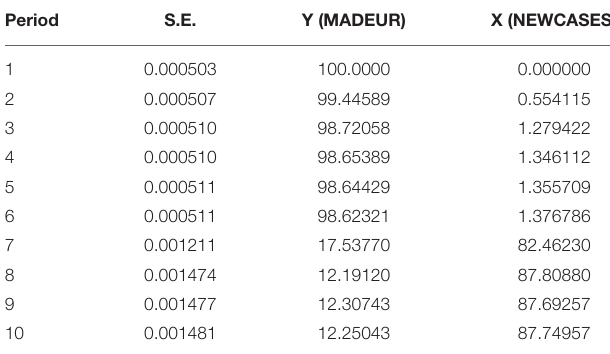
TABLE 7 | Variance decomposition of